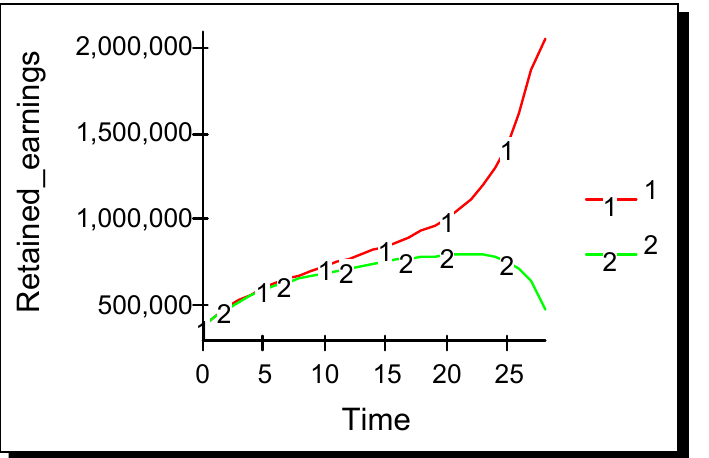
Figure 7. Asymmetric advertising, above threshold. Advertising effectiveness: ϕ 1 = 0.000011; ϕ 2 = 0.0000109.